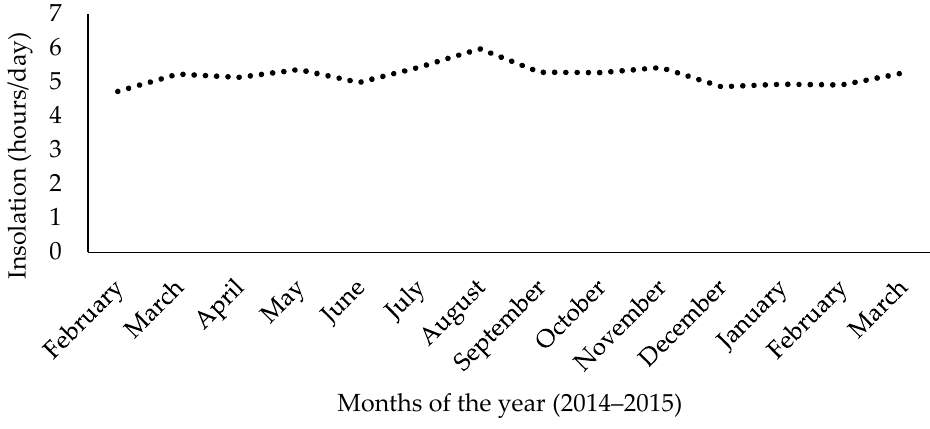
Figure 3. Insolation (hours/day) during the experiment.